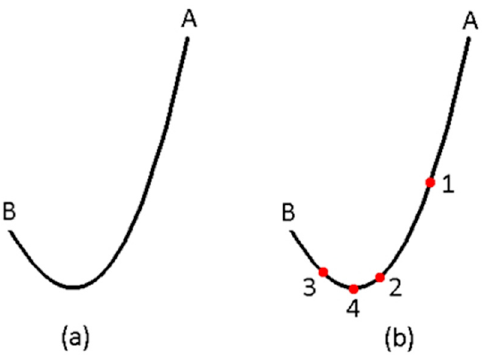
Figure 5. ( a ) Curve is flat on edge A and highly curved on edge B. ( b ) Curve has been subdivided in five sub-curves which fulfill certain criteria of “flatness”